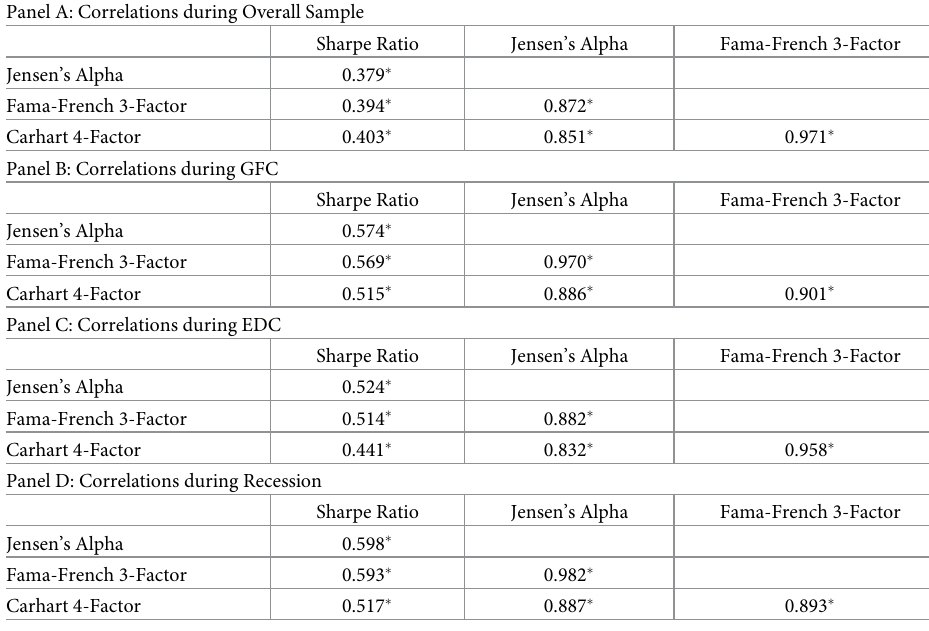
Note : � indicates statistical significance at the 1%